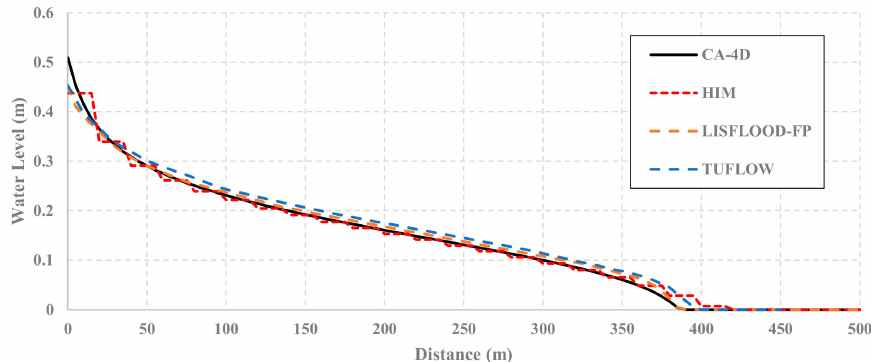
Figure 11. Cross-section of depths along the line y = 1000 m at t = 1